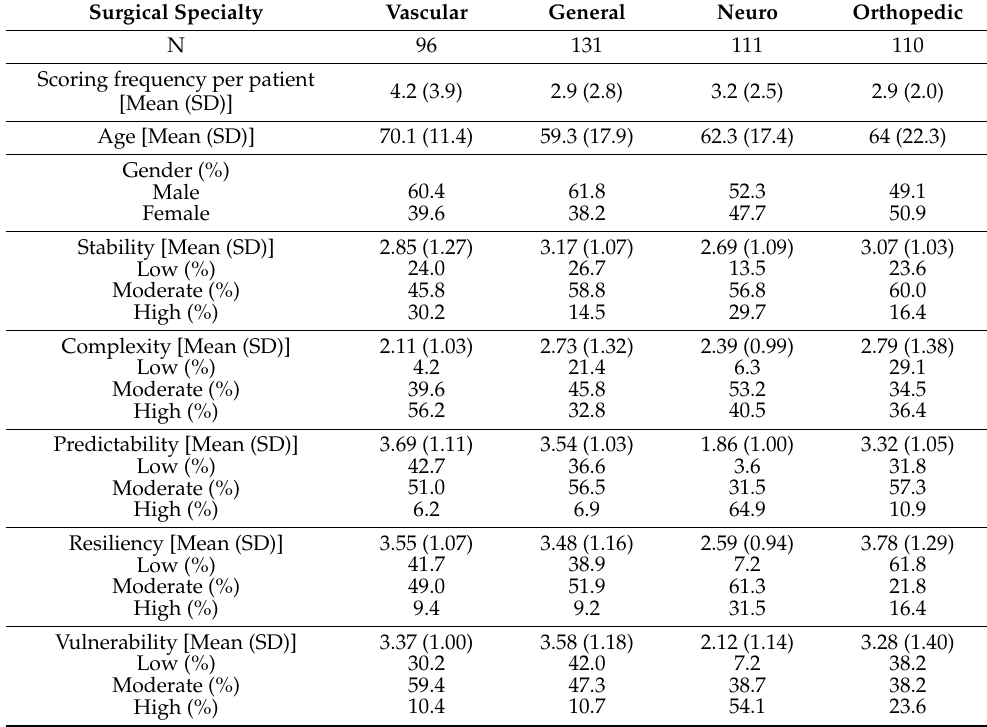
Table 3. Demographics of patients and their Synergy